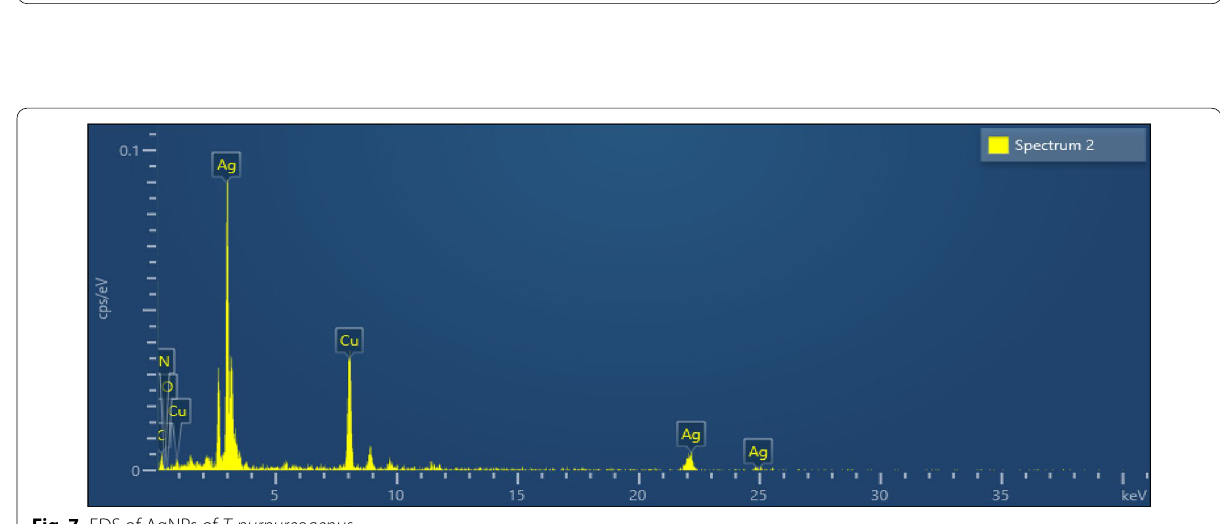
Fig. 7 EDS of AgNPs of T. purpureogenus